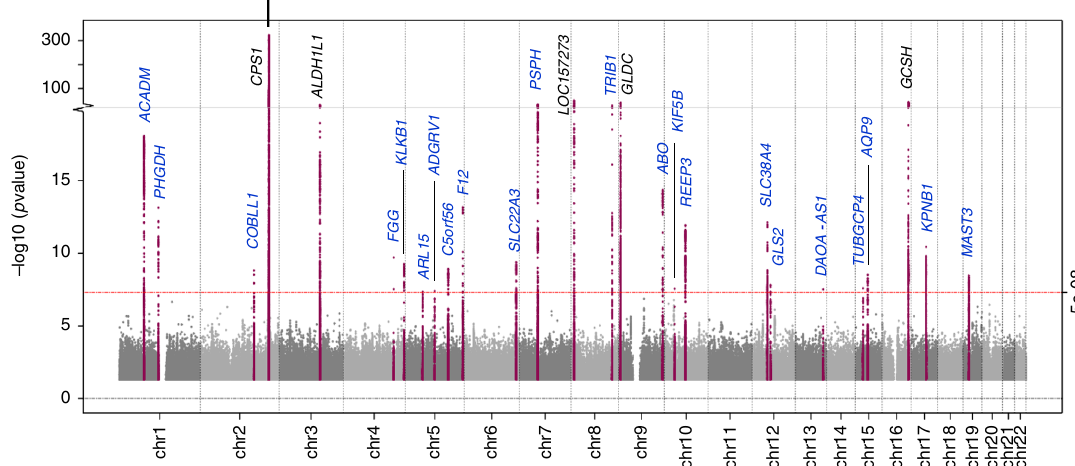
Fig. 1 Manhattan plot of Z score-based meta-analysis of GWAS for glycine levels. Loci in blue have not previously been reported for glycine. P -value for CPS1 locus = 3 × 10 −